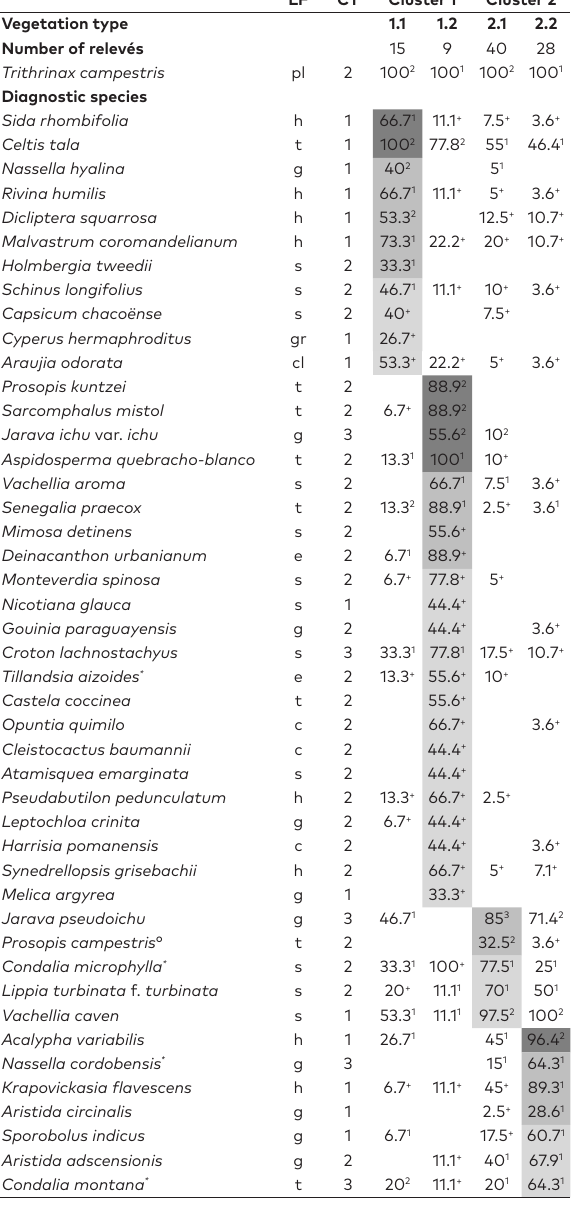
Table 1. Synoptic table of the vegetation types classified by ISOPAM analysis showing the percentage constancy, mean Braun-Blanquet cover (as superscript) and phi values based on 92 relevés collected in Córdoba province, central Argentina. Species are sorted by decreasing fidelity within each vegetation type. Dark, medium and light grey indi- cates phi ≥ 0.3, phi ≥ 0.2 and phi ≥ 0.1, respectively. Vegeta- tion type codes: 1.1 Celtis tala / Sida rhombifolia closed for- est; 1.2 Aspidosperma quebracho-blanco / Prosopis kuntzei open forest; 2.1 Jarava pseudoichu / Vachellia caven open savanna; 2.2 Acalypha variabilis / Nassella cordobensis scru- bland. Life forms (LF): c: cactus; cl: climber; e: epiphyte; f: